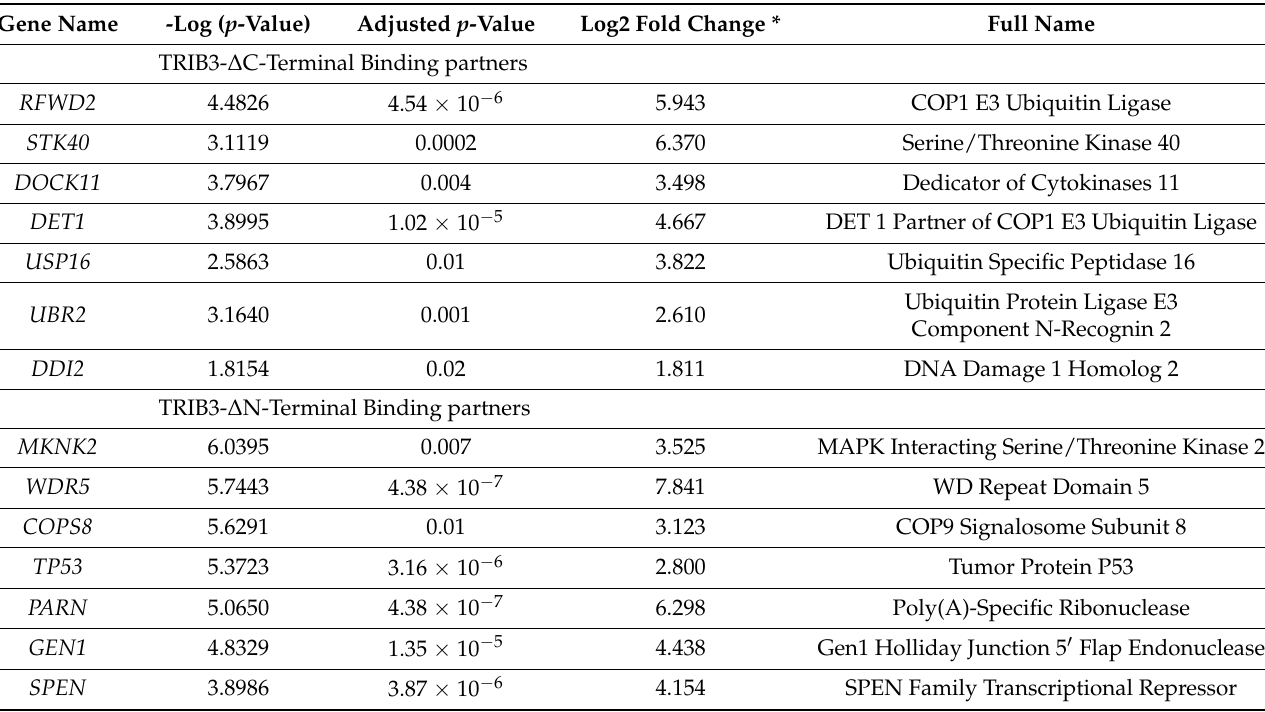
Table 4. Top binding partners of TRIB3 ∆ N- and ∆ C-Terminal domains based on p